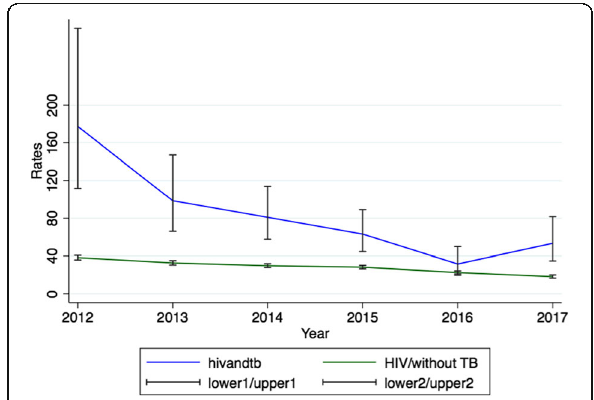
Fig. 2 Trends of mortality over the years per 1000 person-years for HIV and HIV/TB co-infected